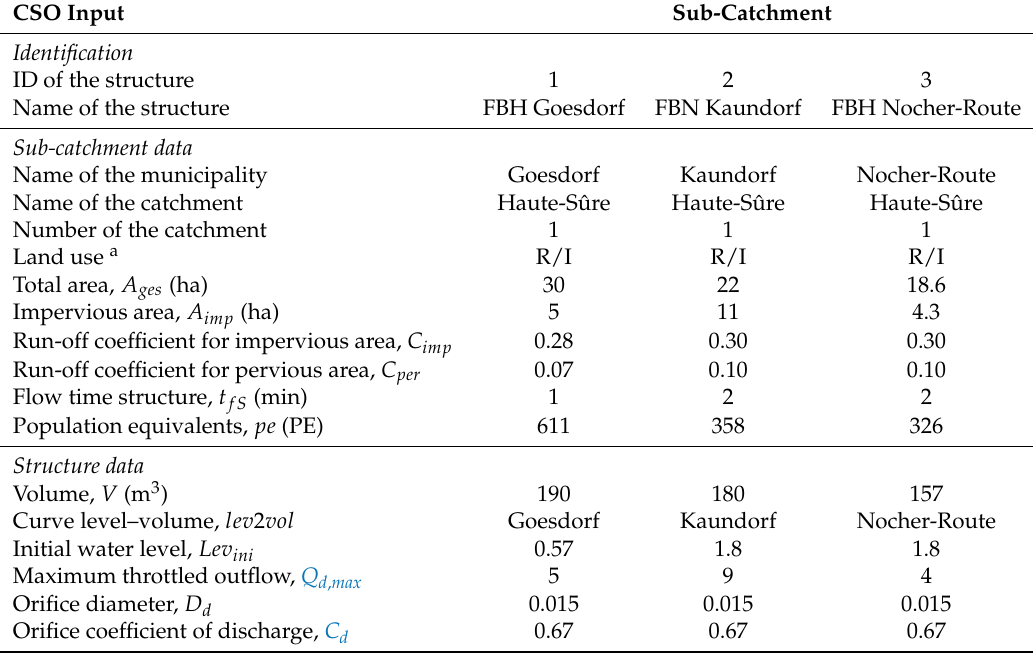
Table 6. General input data of the combined sewer overflow (CSO) structures of the EmiStatR scalability test, after calibration for structure 1. Structures 2 and 3 were not calibrated; therefore, reference values were